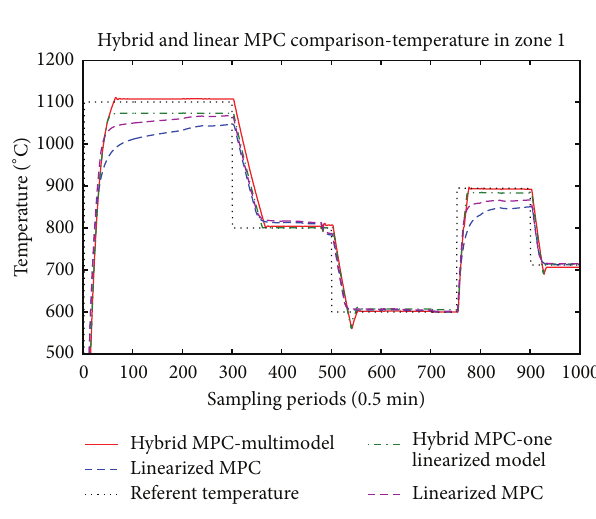
Figure 5: Temperature in the first zone.